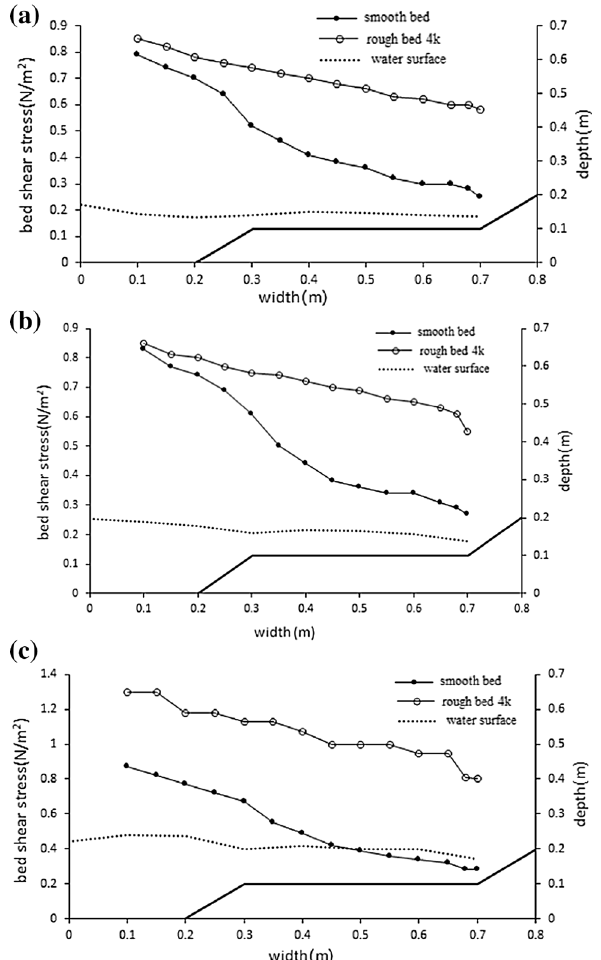
Fig. 7 Comparison of the bed shear stress in a roughened plain with the presence of a pier ( D = 3 cm) and roughened plain (distances of 8 k) a Q 1 , b Q 2 and c Q